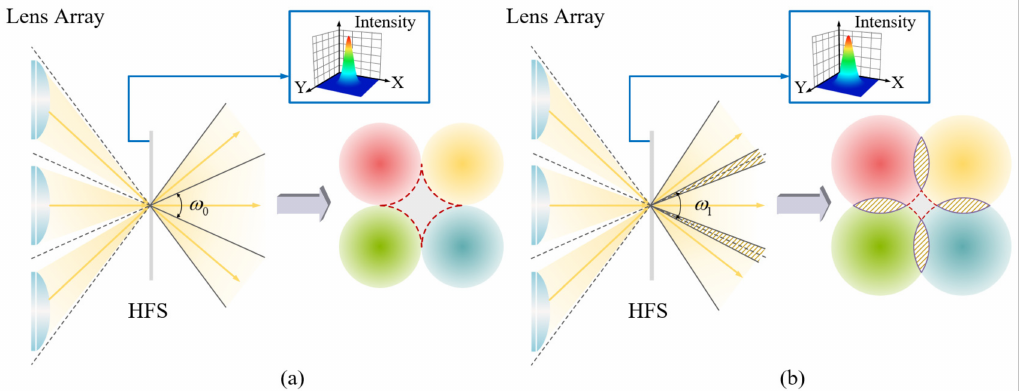
Figure 6. Different spread effects corresponding to different diffusion angles: ( a ) the spread effect corresponding to the optimal diffusion angle; and ( b ) the spread effect corresponding to moderate over